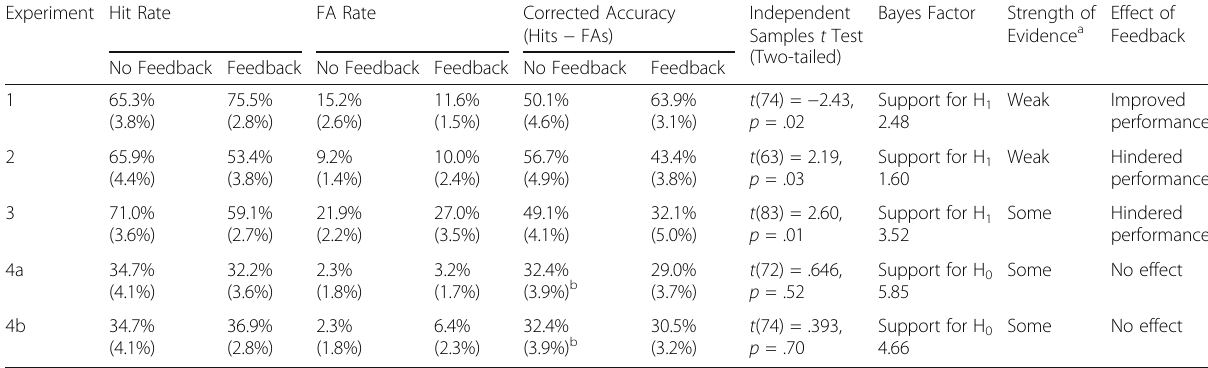
Table 2 Accuracy as a Function of Experiment and Condition Experiment Hit